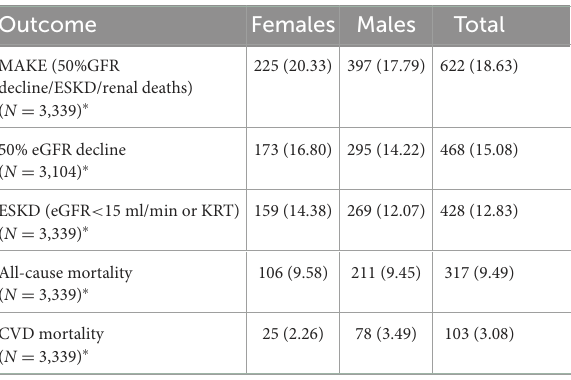
TABLE 3 Outcome events in ICKD cohort at follow-up with median duration of 2.64 (1.40, 3.89)